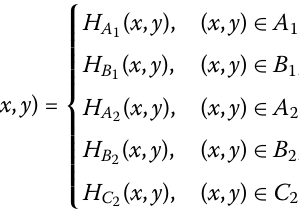
( x 1 , y ), then go to Step 2 i